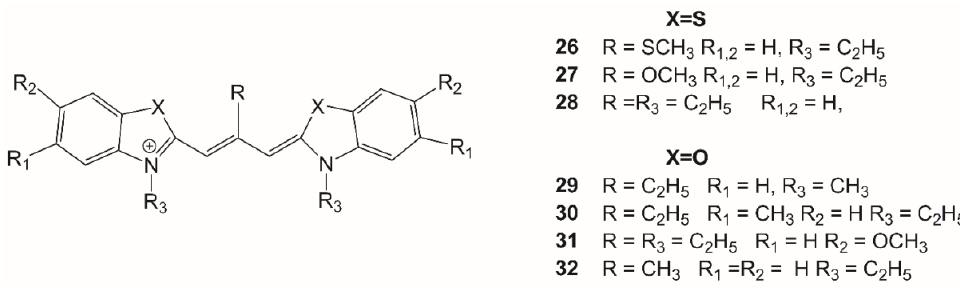
Figure 8. Structures of meso ‐ substituted thia ‐ and oxacarbocyanine dyes 26 – 32.